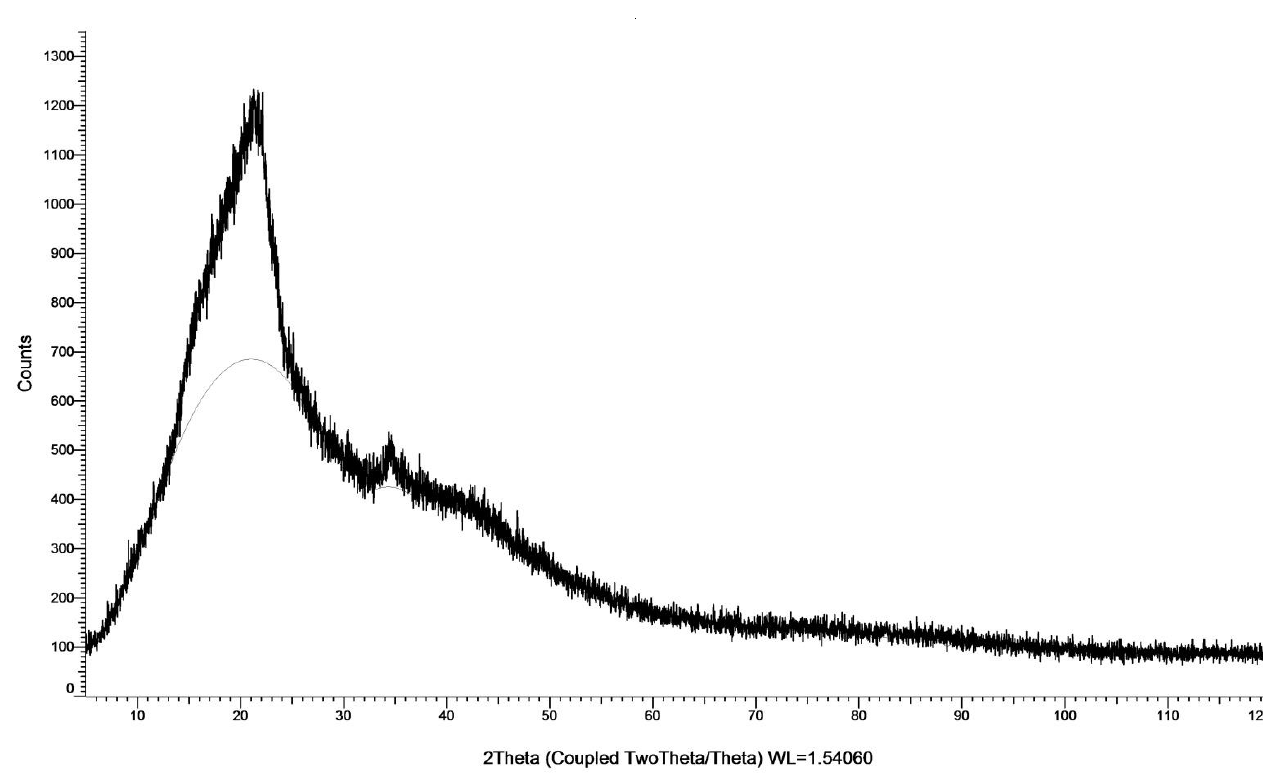
10 of 14 Figure 3. FTIR spectra of corn silk powder. 3.6.3. X-Ray Diffraction The crystallinity index refers to a material ’ s ordered structure. In biomass, cellulose is the only crystalline component, while hemicellulose and lignin are amorphous compo-